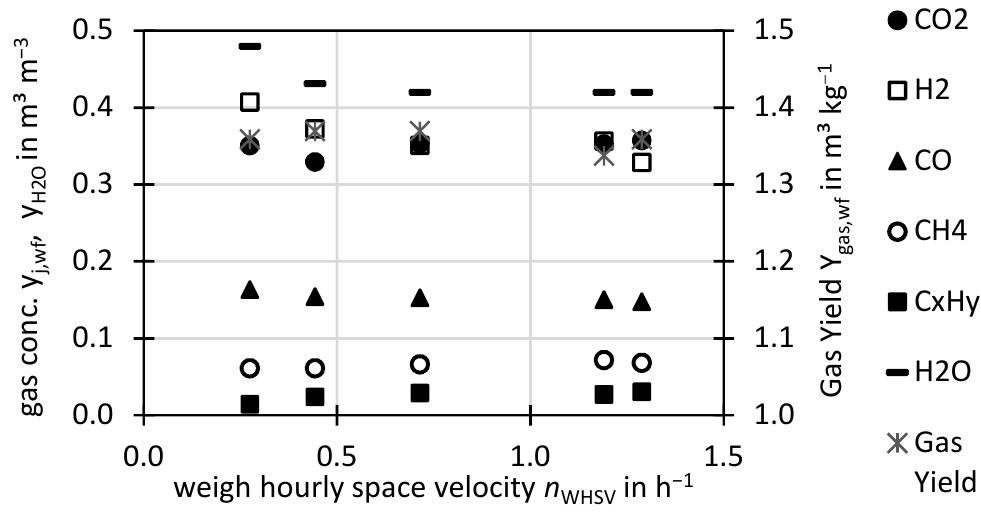
Figure 5. Permanent gas concentrations for different n WHSV in dry N 2 -free basis, for H 2 O wet N 2 -free basis and dry N 2 -free gas yield per dry ash free fuel